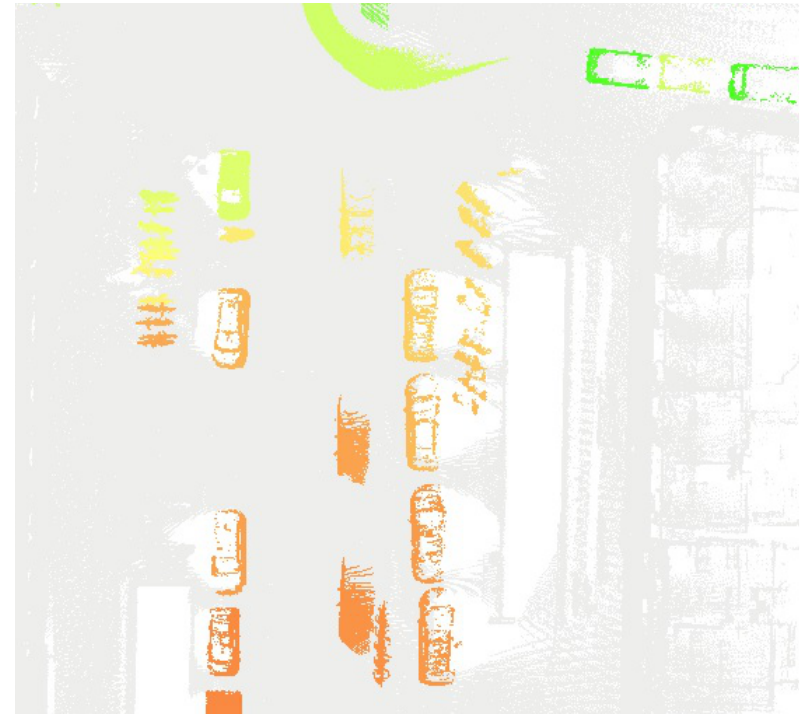
Figure 7. Instances of vehicles in S 3 test set (Paris data).